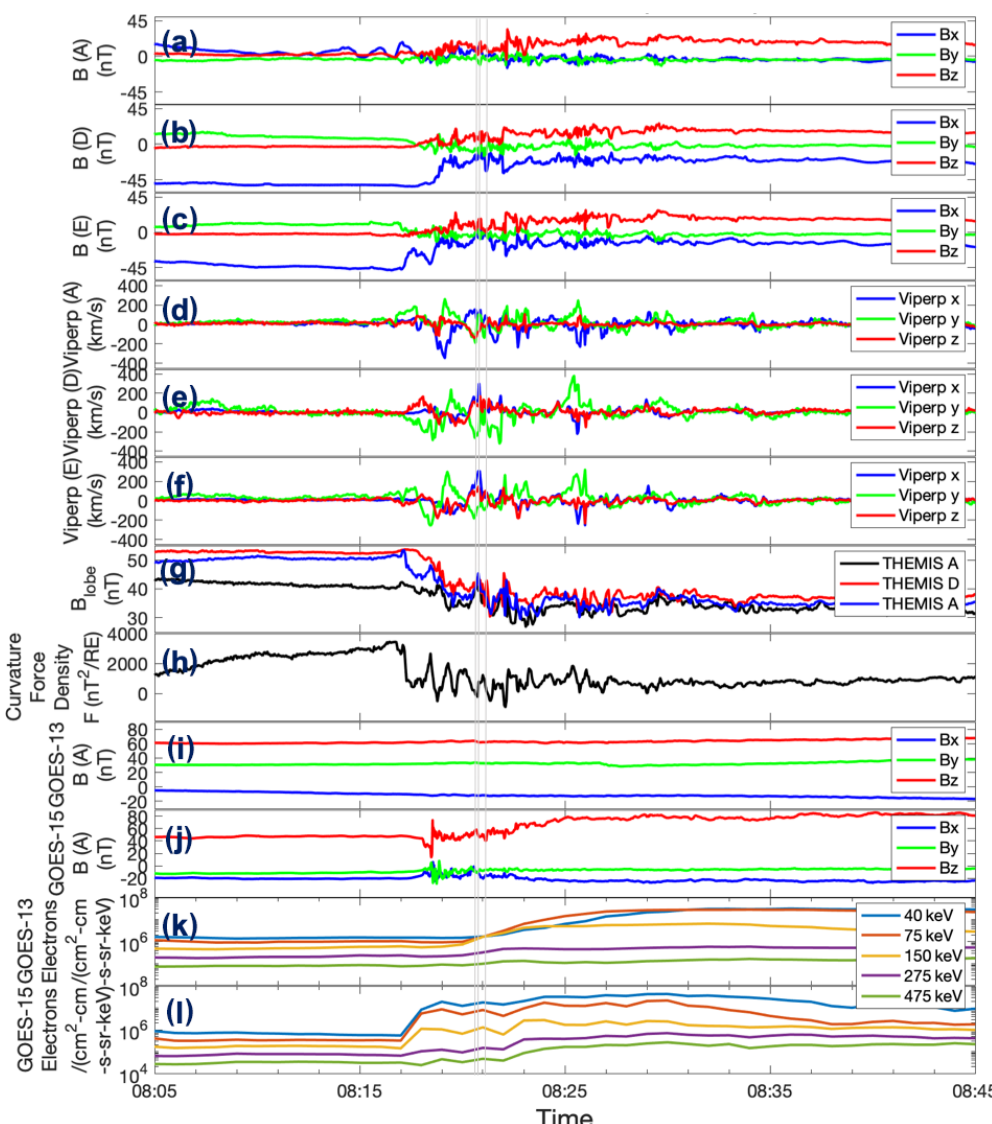
Figure 8. THEMIS and GOES in situ measurements for substorm fast flow burst Case 2 on 25 December 2015. The caption of Fig. 7 applies.